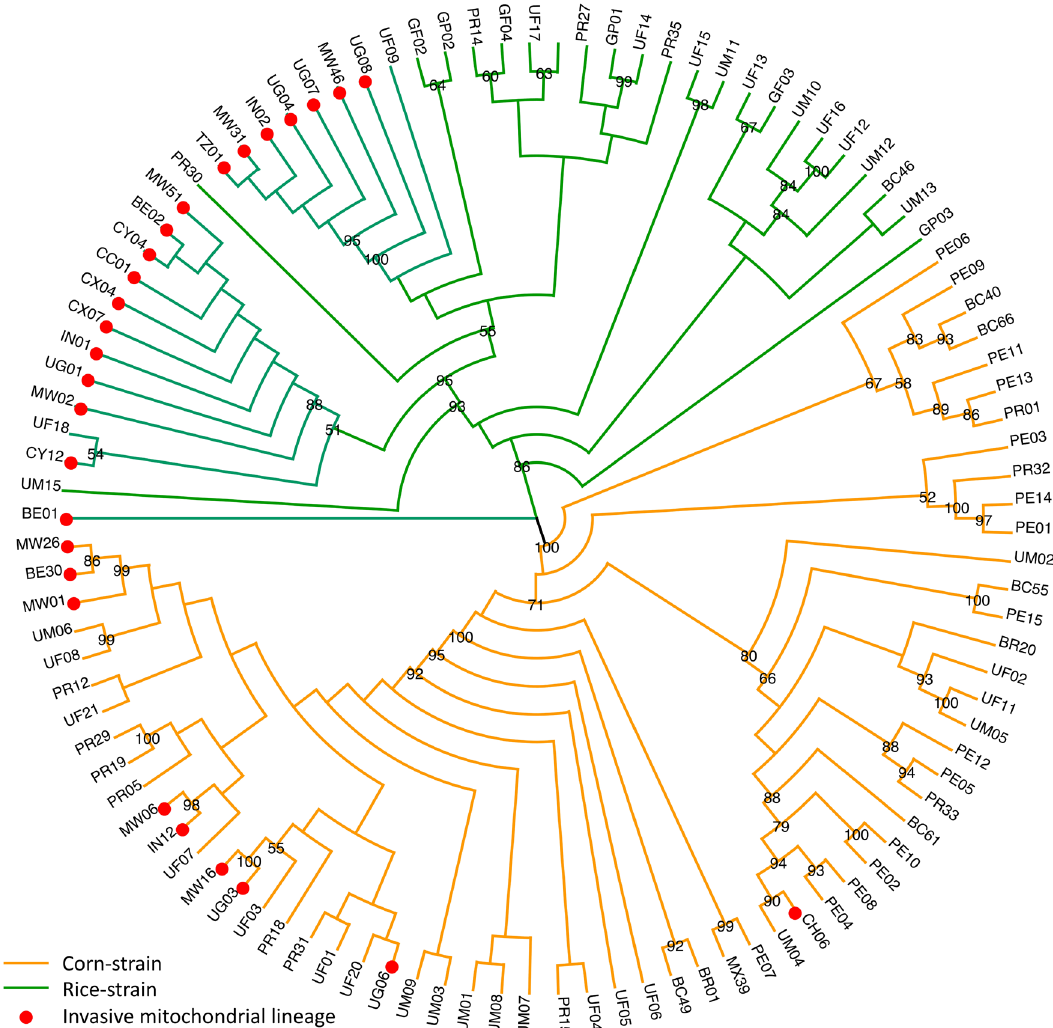
Fig. 2 Partial (15,059 bp) mitochondrial genome Maximum Likelihood phylogeny, showing a clear dichotomy between the rice-strain (green branches) and corn-strain (orange branches) Spodoptera frugiperda . Invasive haplotypes from multiple maternal lineages are indicated by red dots. FAW maximum likelihood phylogeny was constructed using IQ-Tree based on 15,059 bp partial mitochondrial genome with edge-linked partition for the 13 protein-coding genes and excluding four regions of low complexity. Node support is estimated from 1000 bootstrap replications, node support values are shown for ≥ 50%. ‘ Rice ’ clade is indicated by branches in green (native range) and ‘ Corn ’ clade is indicated by branches in orange (native). Unique haplotypes from all populations are included. Country codes are UF (USA-Florida), UM (USA-Mississippi), PR (Puerto Rico), GP (Guadeloupe), GF (French Guiana), PE (Peru), MX (Mexico), BC (Brazil-CC), BR (Brzil-rCC), BE (Benin), UG (Uganda), TZ (Tanzania), MW (Malawi), IN (India), and four populations from China Yunnan Province (Australia pre-border interception (CH06); Cangyuan (CC), Yuanjing (CY), and Xinping (CX)). Invasive mitochondrial lineages are indicated by red